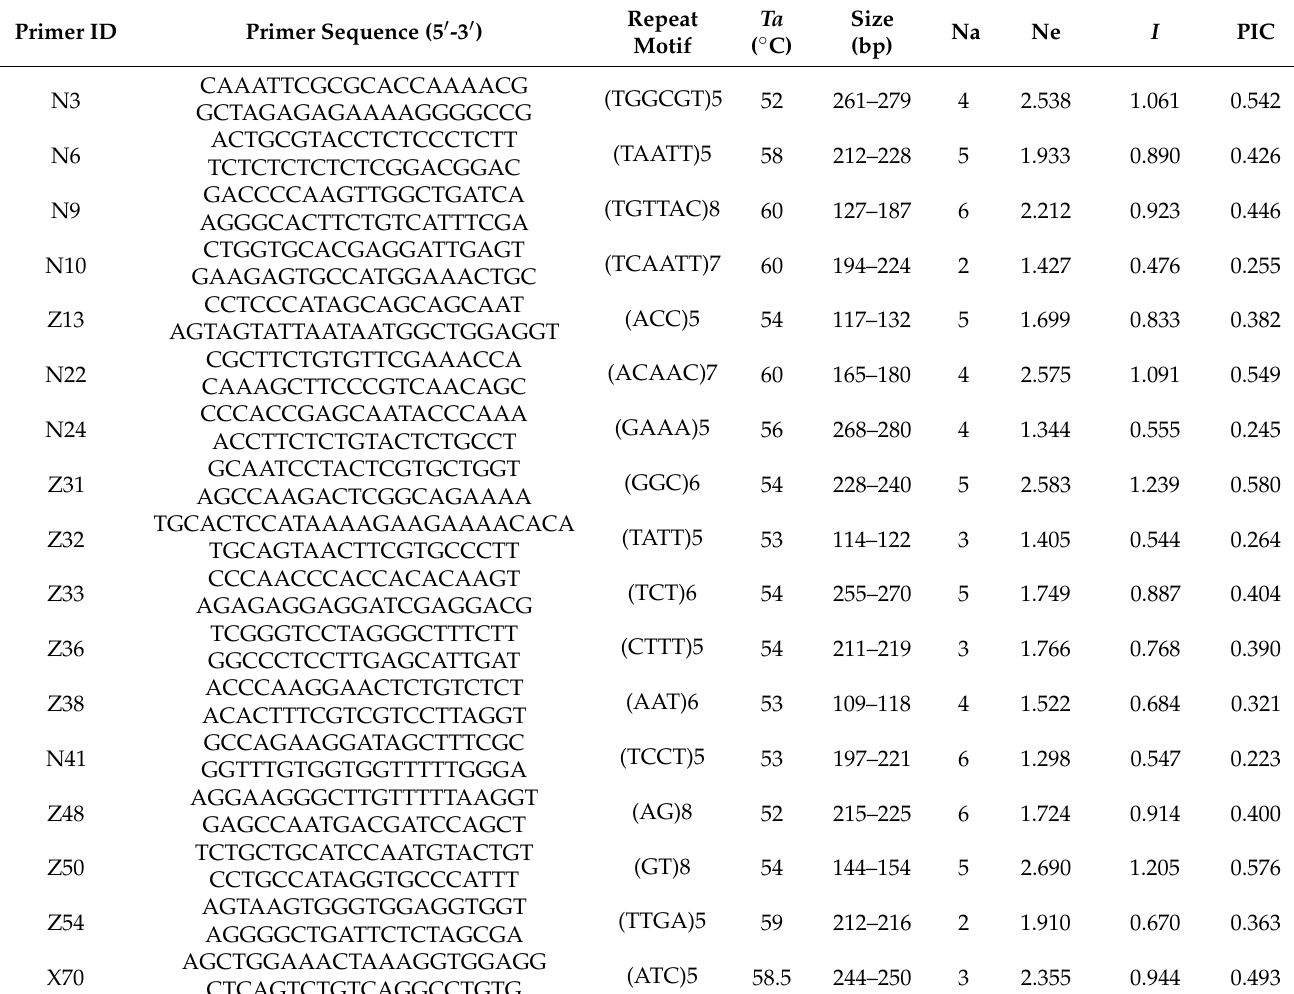
Table 5. The information of 17 EST-SSR primers of L. yunnanensis